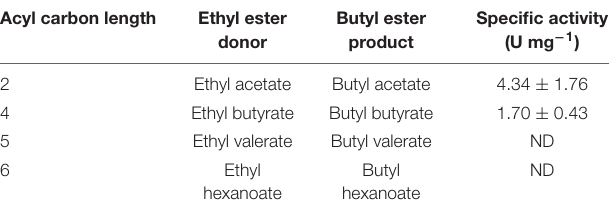
TABLE 4 | Acyl specificity of Eat1 during